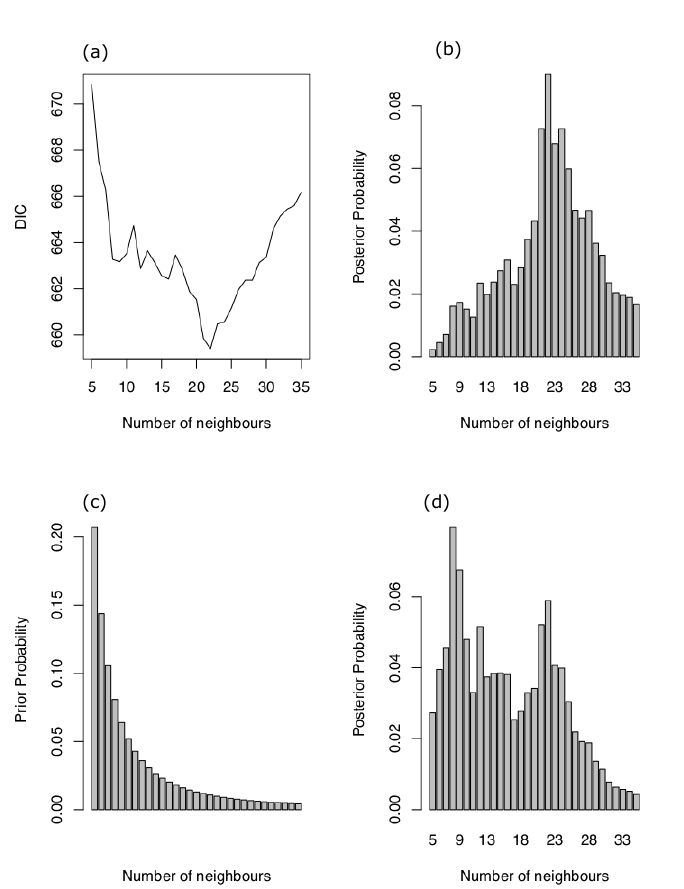
Figure 7. Deviance information criterion ( a ) and posterior probabilities ( b ) for spatial probit models with different adjacency structures based on a nearest neighbours approach using a uniform prior, Katrina business data. Prior ( c ) and posterior ( d ) probabilities for spatial probit models with different adjacency structures based on a nearest neighbours approach using an informative prior, Katrina business